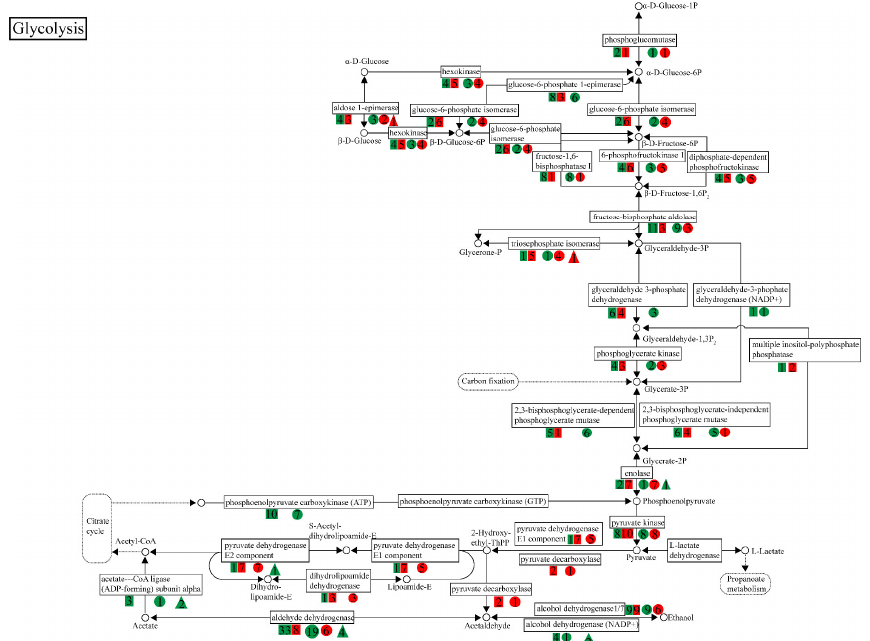
Figure A2. DEGs in glycolysis. Squares represent DEGs based on the comparison between gall vs. LWG; circles represent DEGs based on the comparison between gall vs. LNG; triangles represent DEGs based on the comparison between LNG vs. LWG. Red color indicates up-regulation and green color indicates down-regulation. The numbers within shaded shapes indicate the number of genes. There were 104 genes up-regulated and 142 genes down-regulated based on the comparison between gall vs. LWG, 81 genes up-regulated and 107 genes down-regulated based on the comparison between gall vs. LNG, two genes up-regulated and 11 genes down-regulated based on the comparison between LNG vs. LWG. In general, genes involved in glycolysis were down-regulated. Int. J. Mol. Sci. 2021 , 22 , x FOR PEER REVIEW